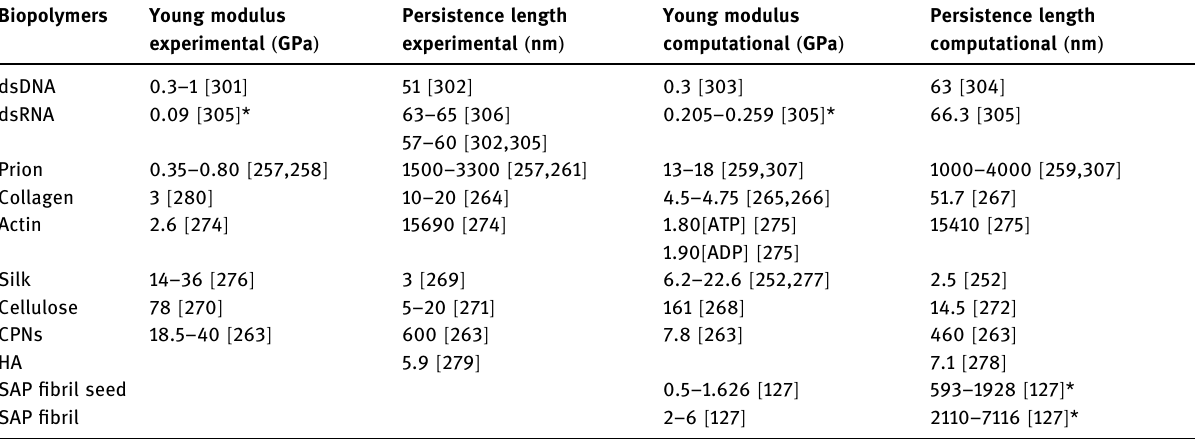
Table 3: Experimental and computational characterization of the most important SBPs used in TE and nanomedicine